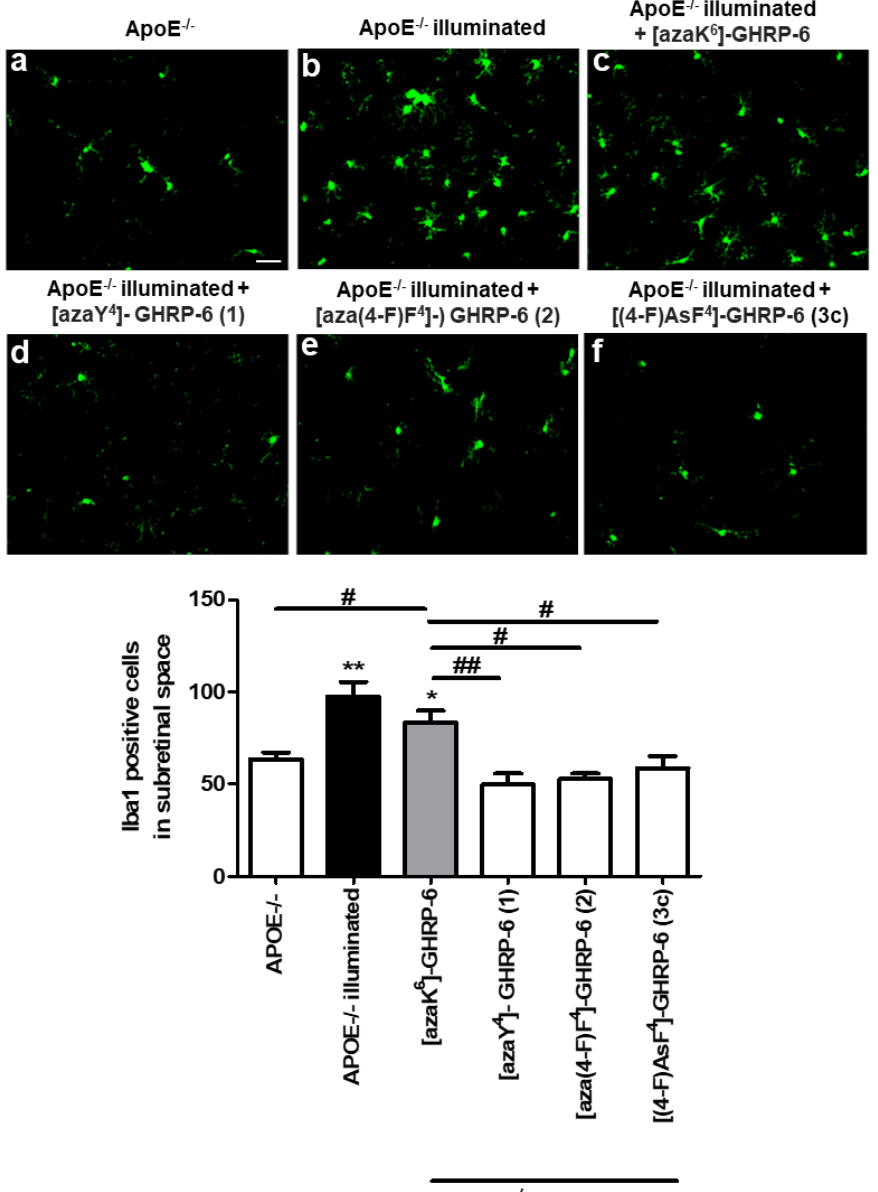
Figure 4. Anti-inflammatory effect of [(4-F)AsF 4 ]-GHRP-6 ( 3c ), [azaY 4 ]- GHRP-6 ( 1 ), [aza(4-F)F 4 ]-GHRP-6 ( 2 ), and [azaK 6 ]-GHRP-6 (negative control) in blue light illumination model. Representative complex RPE/choroid/sclera flat-mounted illustrating the accumulation of positive IBA-1 cells (green) in the subretinal space of ApoE − / − mice non-illuminated, exposed to 1000 Lux blue-light treated or not with CD36 ligands. Quantification of IBA-1 positive cells in the subretinal space of the mouse are presented in histogram (* P < 0.05, ** P < 0.01 compared to APOE − / − , # P < 0.05 ## P < 0.01 compared to [azaK 6 ]-GHRP-6, n = 3–5. Scale bar = 30 µm.